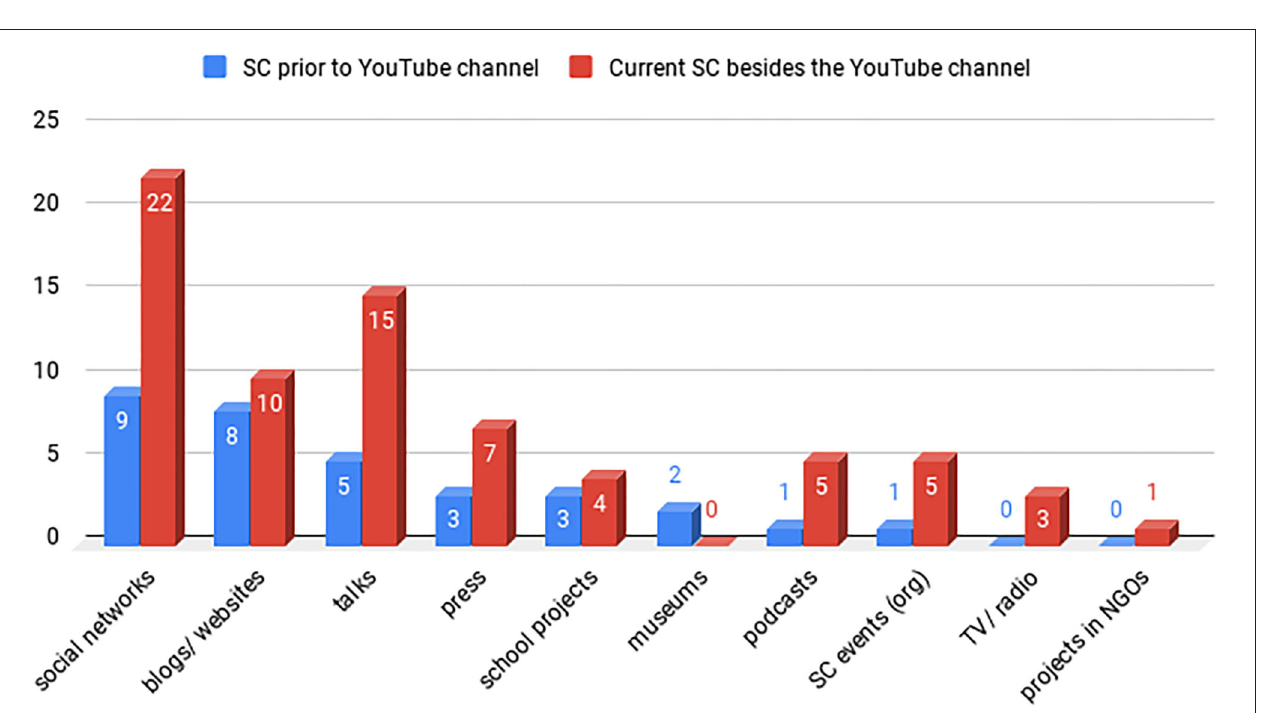
FIGURE 6 | SC activities prior and concurrent with the YouTube channel.